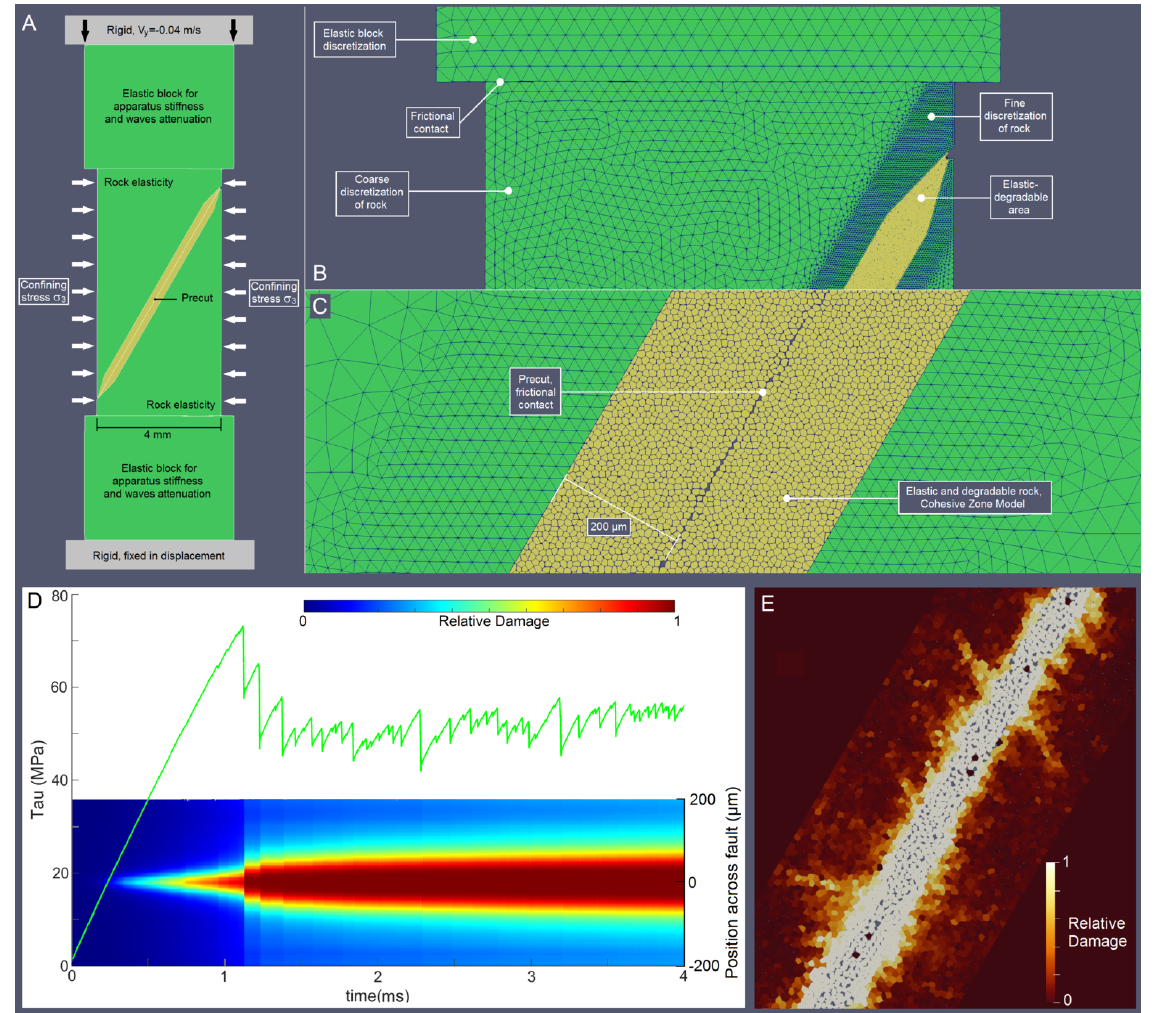
Figure 4: A model for laboratory earthquakes combining several relevant scales [59]. A : Full view of the model with a precut deformable rock sample submitted to a confining lateral stress and placed between two deformable blocks (mimicking the compliance of the loading system), submitted to vertical compression; B : View of the mesh of the upper area of the system (notice the refined mesh in the vicinity of the contacting surfaces); C : Zoom on the initially intact interface, composed of rigid conforming polygons linked by a Cohesive Zone Model which can damage and break during sliding; D : Typical loading curve showing alternating stick (elastic increase of the load) and slip (sudden stress drop) periods of various durations and intensities, in good synchronicity with the average profile of damage in the fault; E : Snapshot of a small area of the contact showing the layer of granular gouge released in the interface, the damage distribution of the surfaces, and fracture